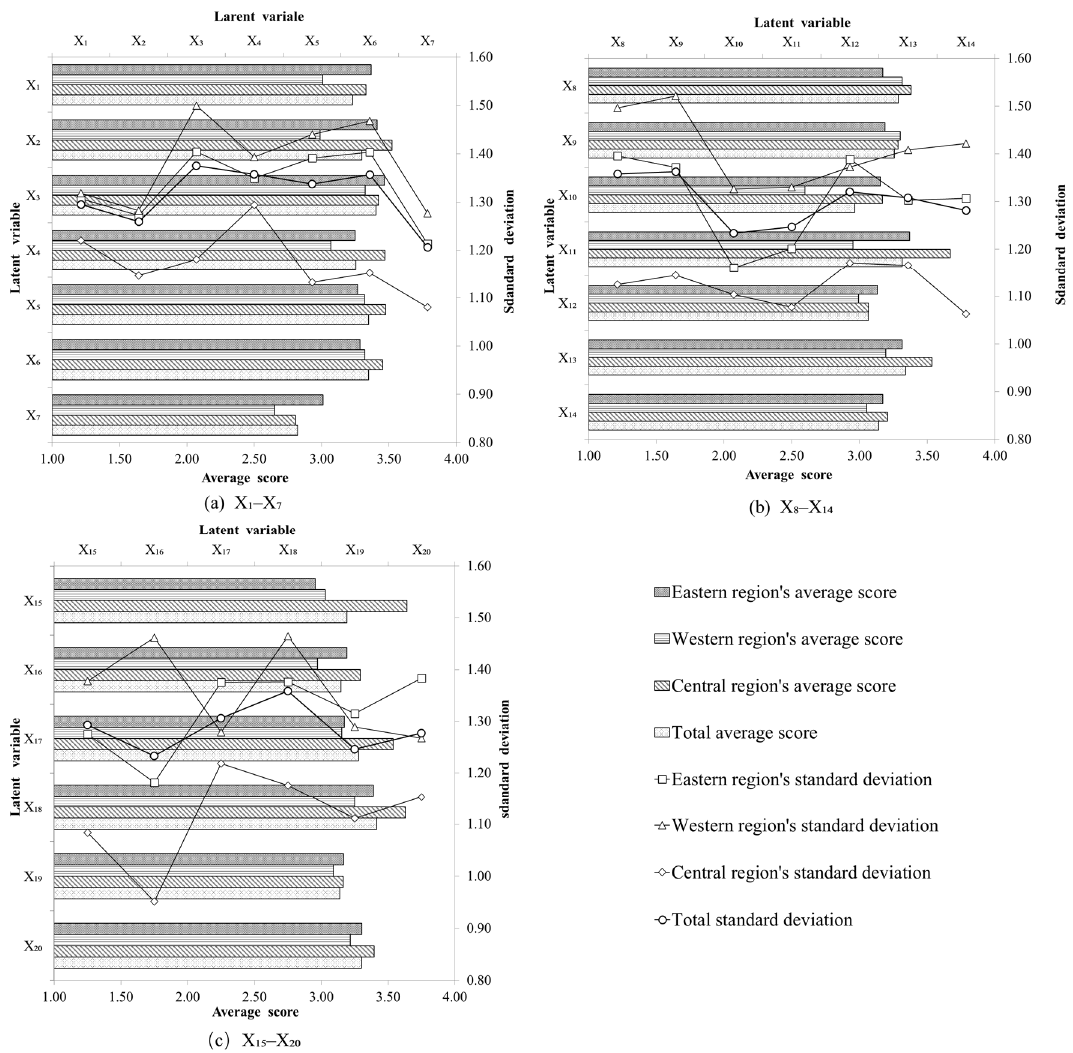
Figure 4. Regional values of latent variables.